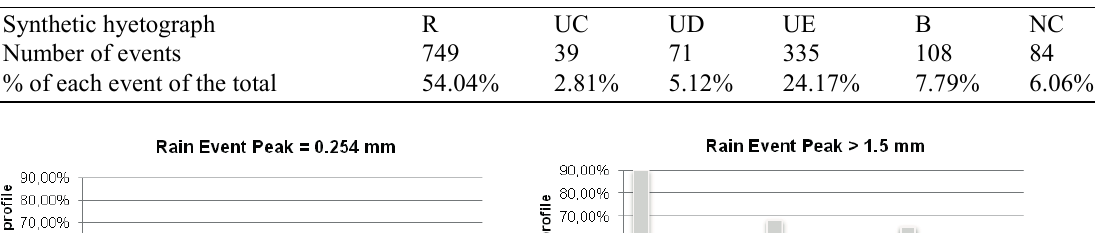
Table 3 Distribution of rainfall event shapes.